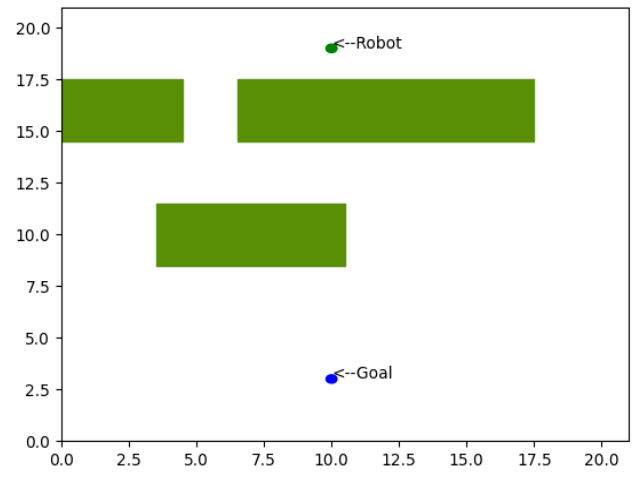
Figure 7. Robot working environment.